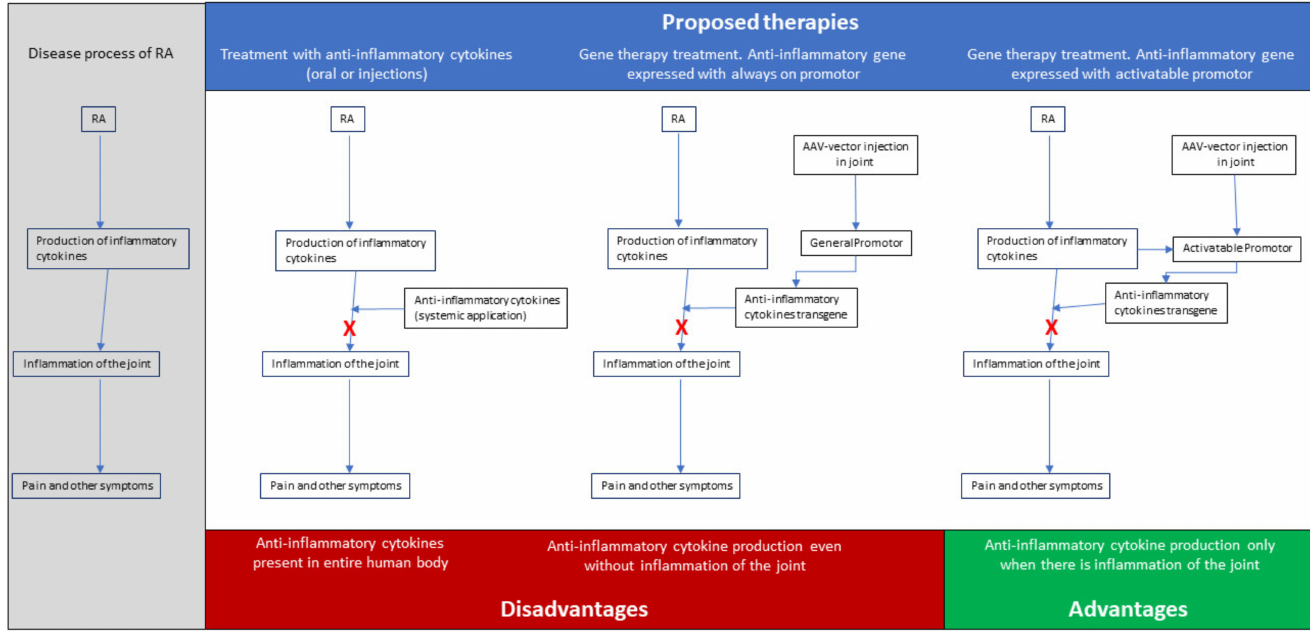
Figure 1. Schematic representation of a proposed treatment of Rheumatoid Arthritis (RA) with gene therapy